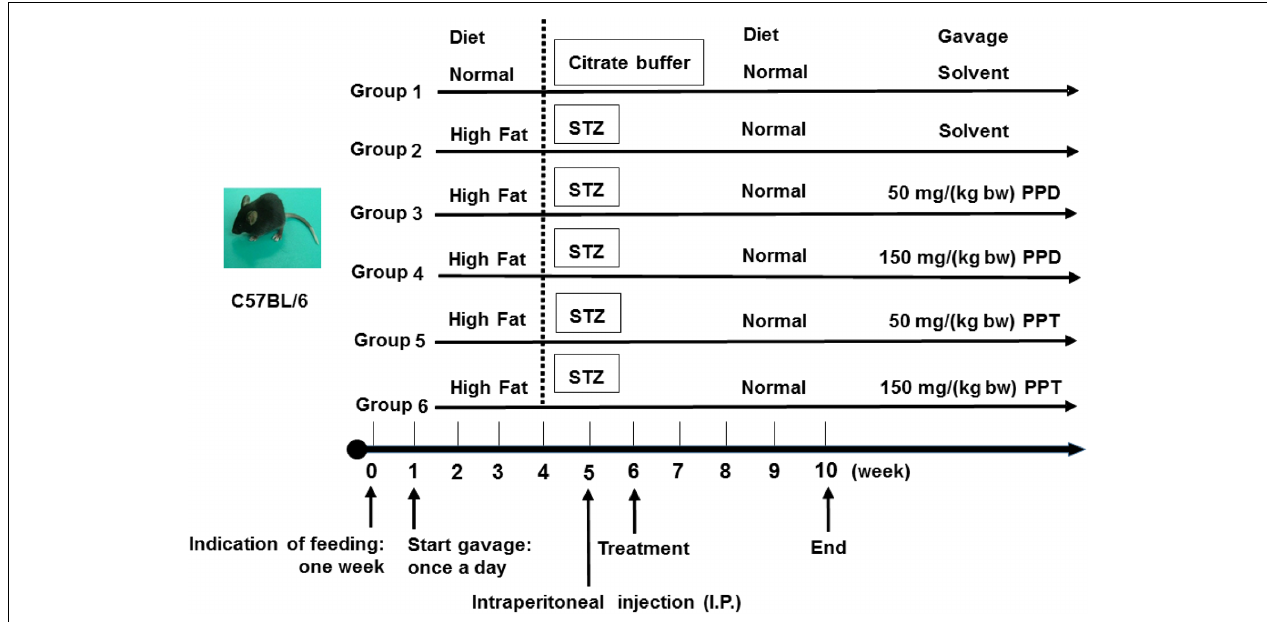
FIGURE 1 | Animal experimental design. Group 1, NDC group; Group 2, DC group; Group 3, LPPD group; Group 4, HPPD group; Group 5, LPPT group; Group 6, HPPT